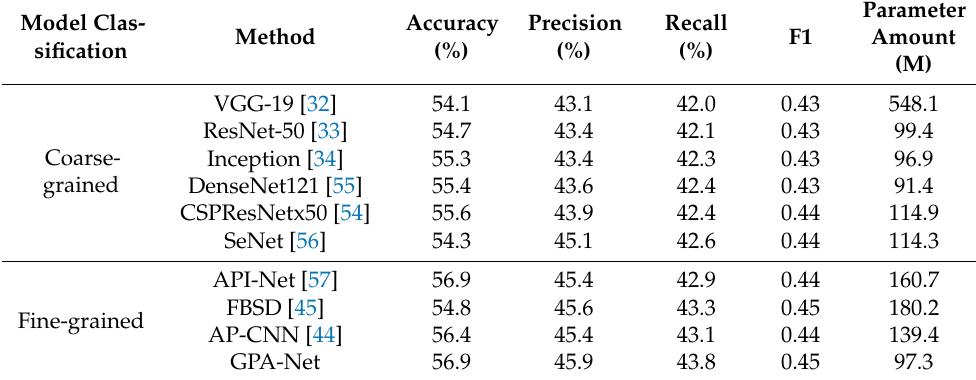
Table 3. Contrast performance on the IP102